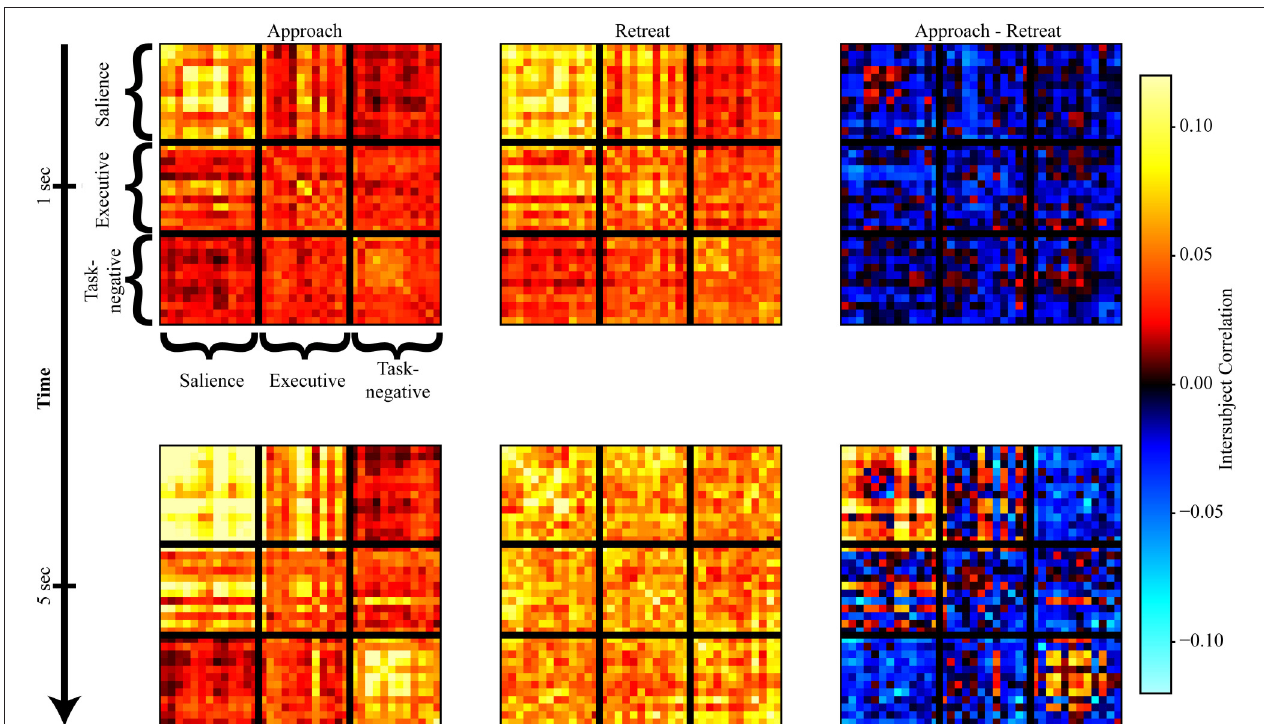
FIGURE 6 | Snapshots of intersubject correlation matrices. Results are shown for approach and retreat conditions, as well as approach minus retreat. The top row shows intersubject correlations at t = 1s, and the bottom row shows intersubject correlations at t = 5s (in both cases, a hemodynamic lag of 5s was